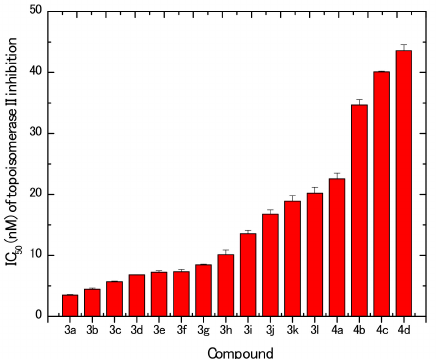
Figure 3. IC 50 of Topoisomerase II Inhibitor activities of the tested compounds.